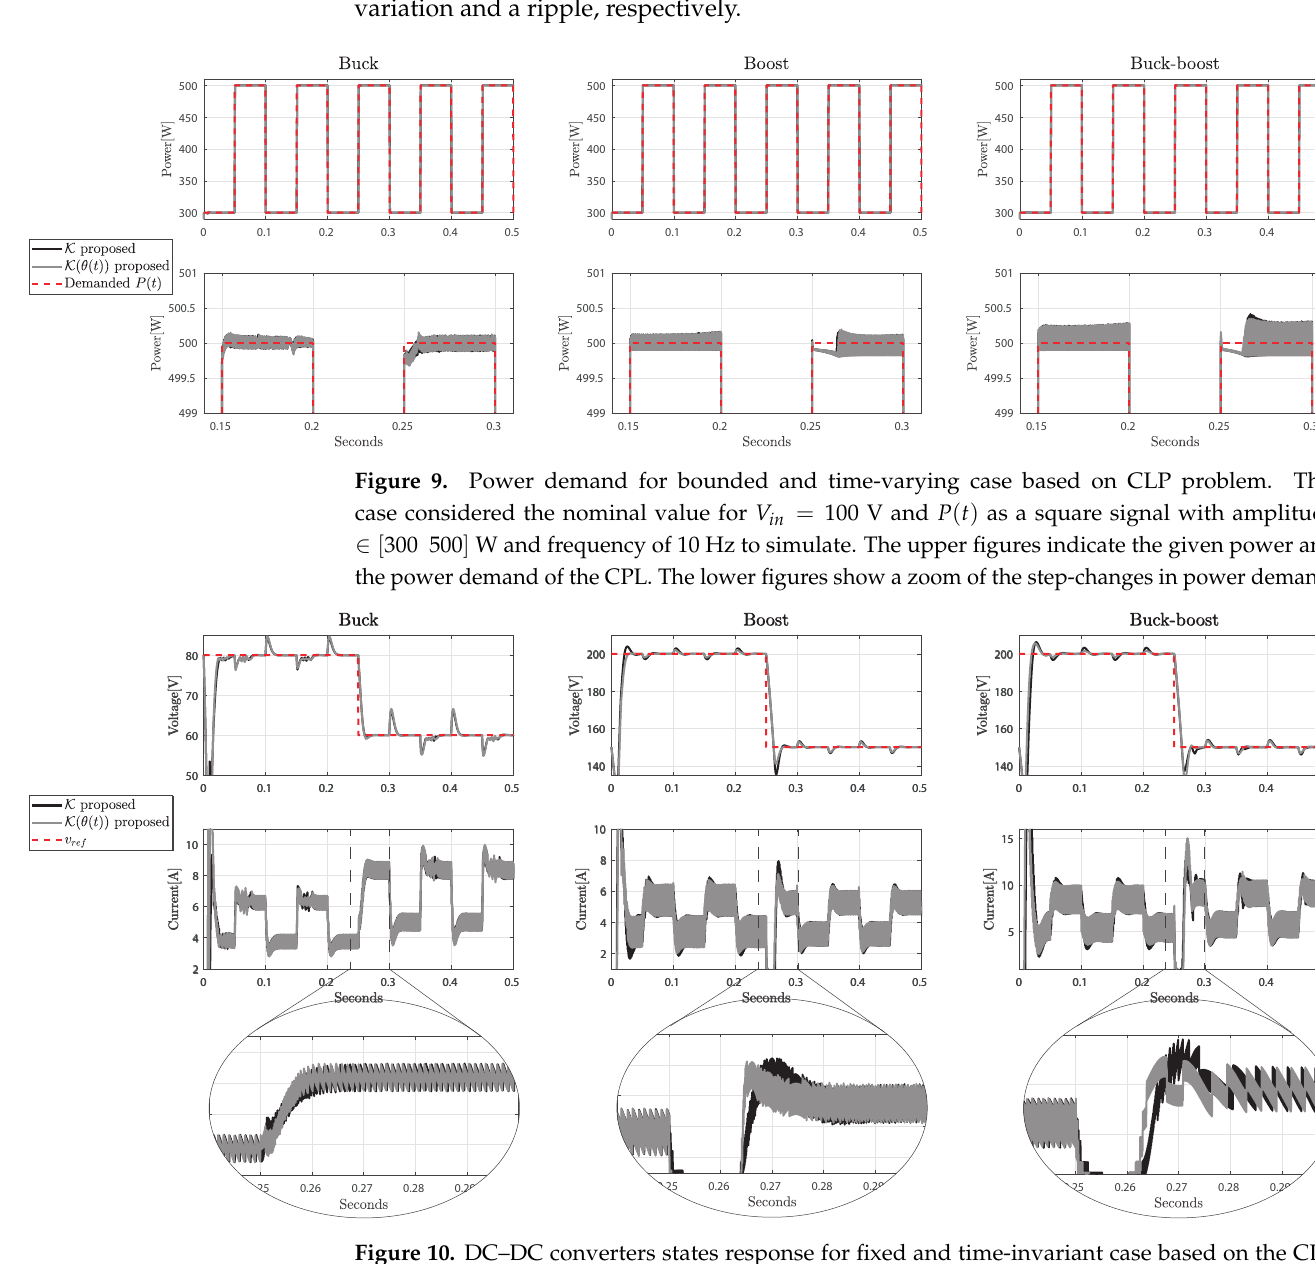
Figure 10. DC–DC converters states response for fixed and time-invariant case based on the CLP problem. This case considered the nominal value for V in = 100 V and P ( t ) as a square signal with amplitude ∈ [ 300 500 ] W and frequency of 10 Hz to simulate. The upper figures indicate the voltage and the setpoint on the three converters. The lower figures show the current obtained in the inductor. A zoom to the current plot is also